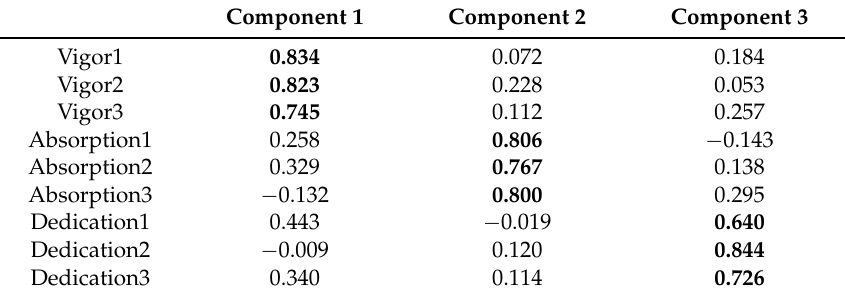
Table 6. Rotated component matrix of customer engagement.